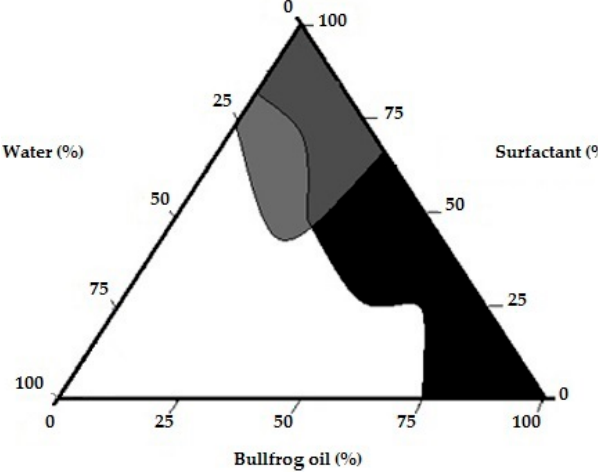
Figure 2. Pseudo-ternary phase diagram of the bullfrog oil produced with HLBr 12.1. Black (phase separation), dark gray (microemulsion), medium gray (gel), white (emulsion).